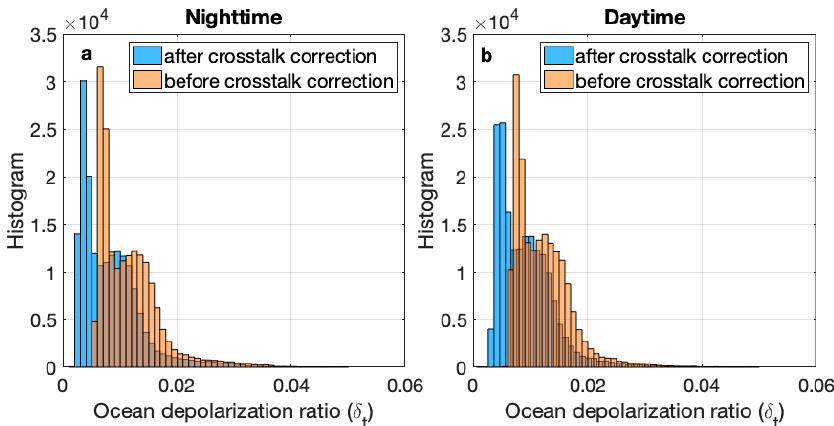
Figure 7. Ocean total depolarization ratio comparisons after (sky blue color) and before (orange color) crosstalk corrections during ( a ) nighttime and ( b ) daytime.